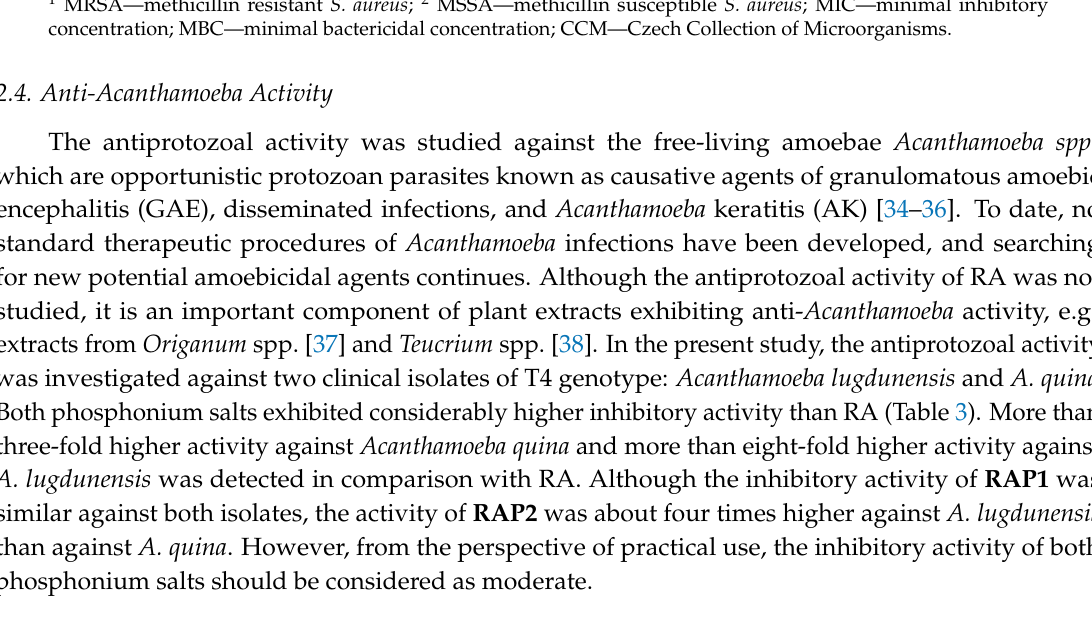
Table 3. The values of EC50 (mM) of RA and its phosphonium salts RAP1 and RAP2 on Acanthamoeba trophozoites after 24 h of